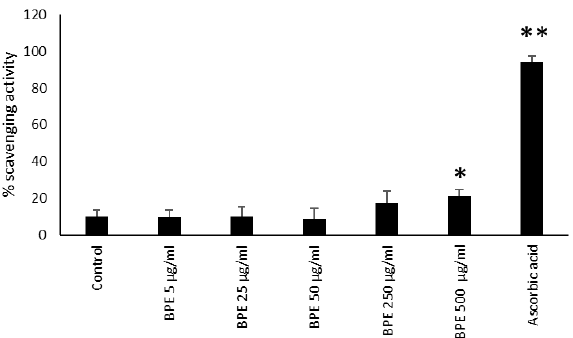
Figure 11. BPE radical scavenging capacity by DPPH method. Results are expressed as percentage of DPPH scavenging activity. Data represent the mean ± standard deviation (SD) of two independent experiments performed in triplicate. The statistical analysis was performed with a two- tailed Student ’s t- test. * p < 0.05, ** p < 0.01 (BPE-, ascorbic-acid- treated cells vs. ethanol-treated cells).